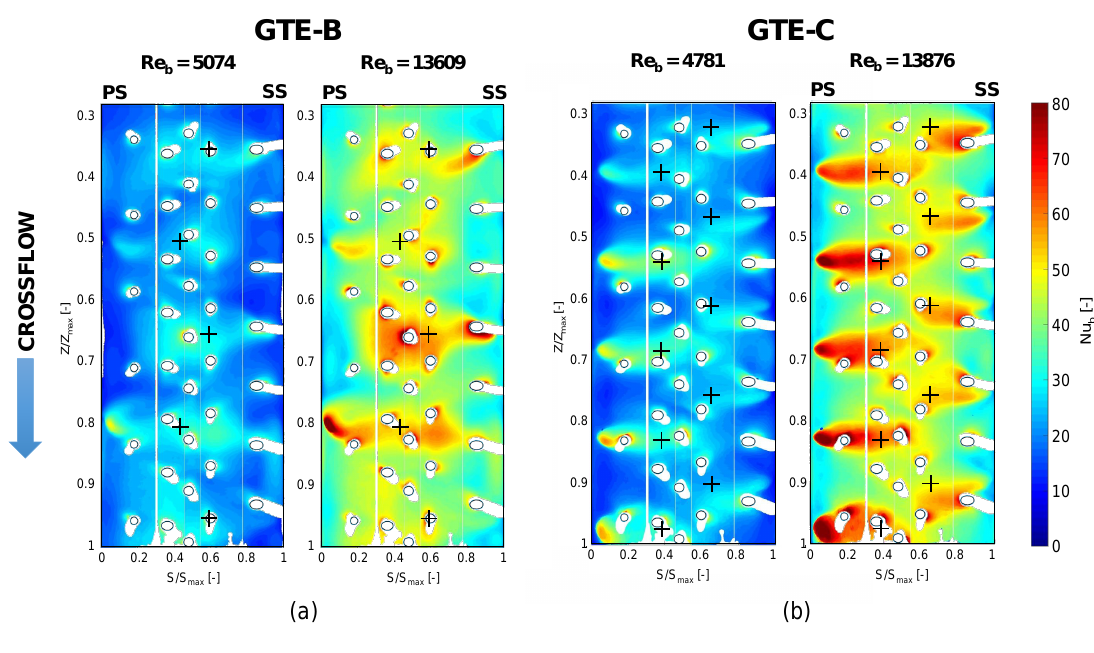
Figure 3. Nu b distributions for Cr = 40%, Ro b = 0 for ( a ) GTE-B and ( b ) GTE-C